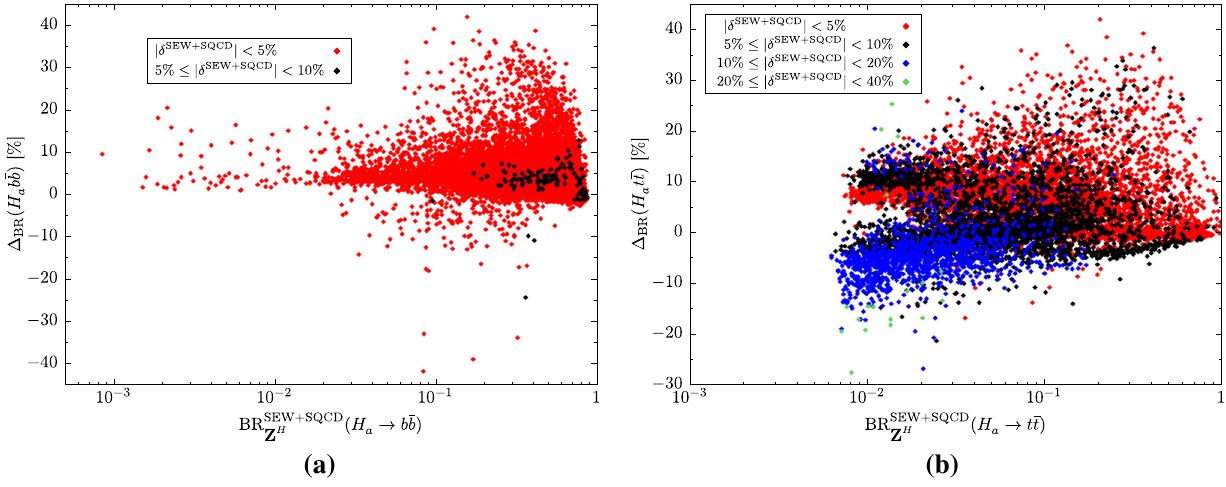
Fig. 5 Scan2: Same as Fig. 2 but for the heavier a -like Higgs boson H a decaying into b ¯ b (left) and t ¯ t (right) ( H → W + W − ) . The plotted points are those BR SEW h d Z H